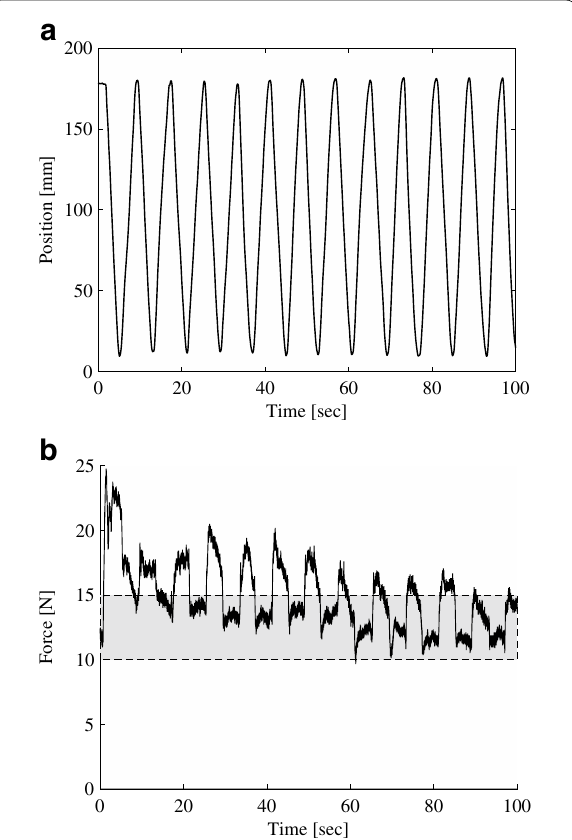
Fig. 12 In the experiments conducted using our proposed sensor, the graphs show a the position and b pressing force for each